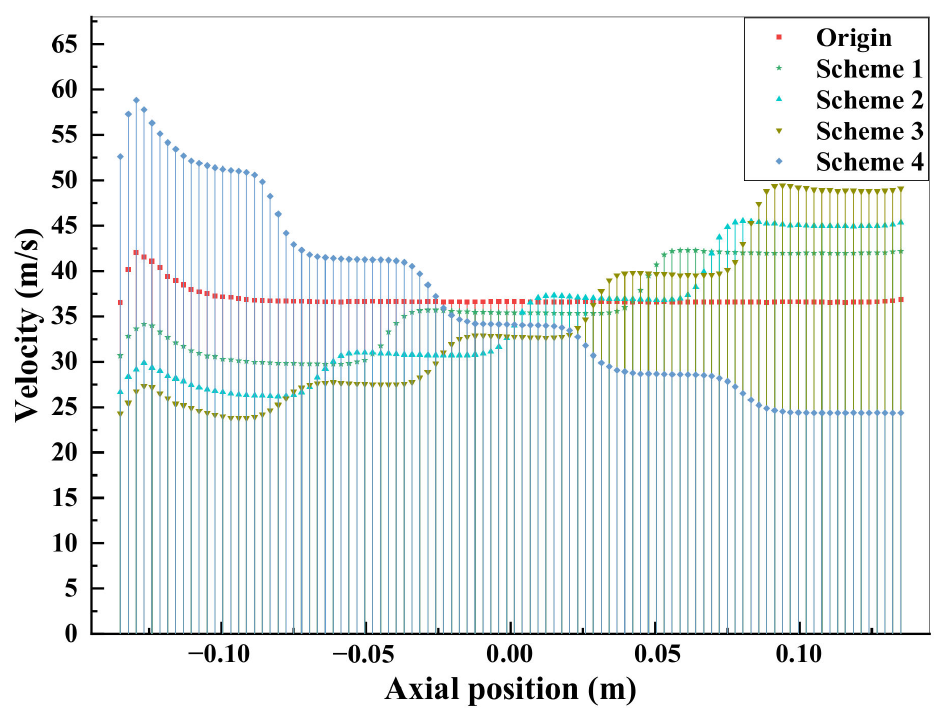
Figure 9. Axial velocity comparison of nonlinear variable cross-section stator ventilation schemes.